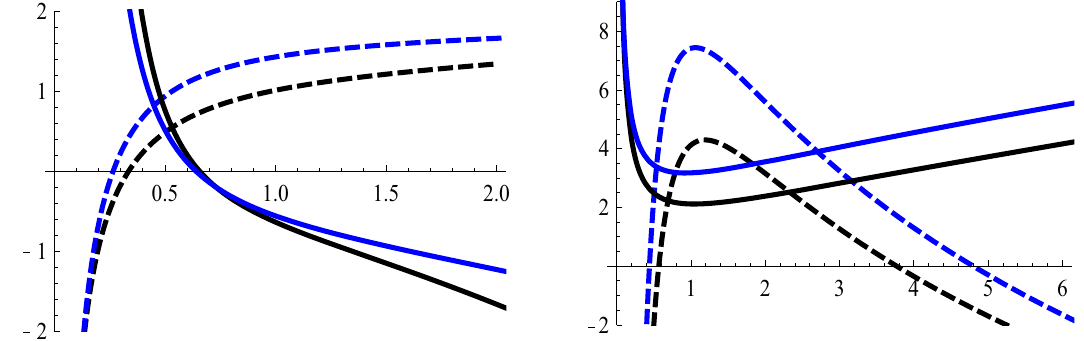
the horizon radii in the range r 1 < r + < r 2 are in the radia- tion phase. They undergo Hawking–Page phase transition at the points r + = r 1 and r + = r 2 . The physical black holes with the horizon radii in the ranges r 1 ext < r + < r 1 and r 2 < r + < r 2 ext are globally